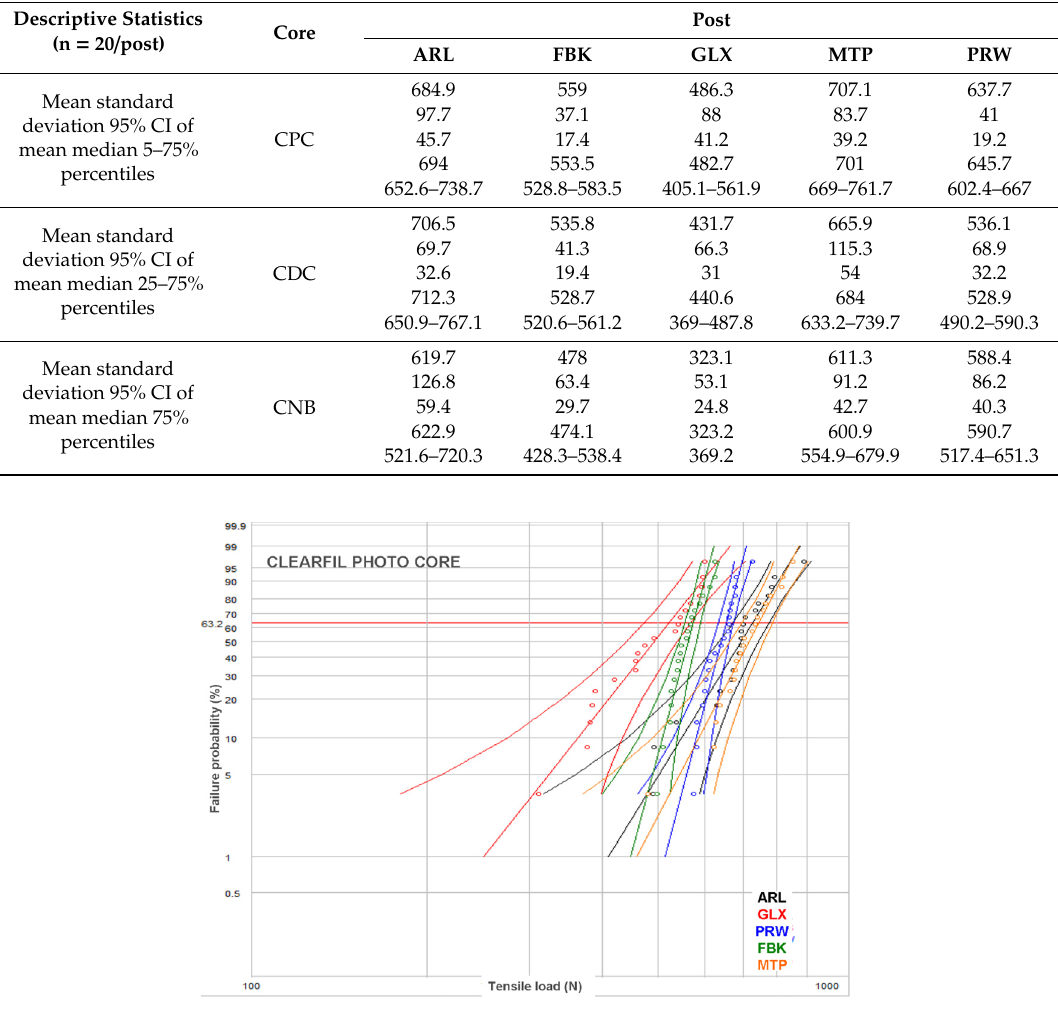
Figure 4. Weibull plot for the posts restored with CPC.